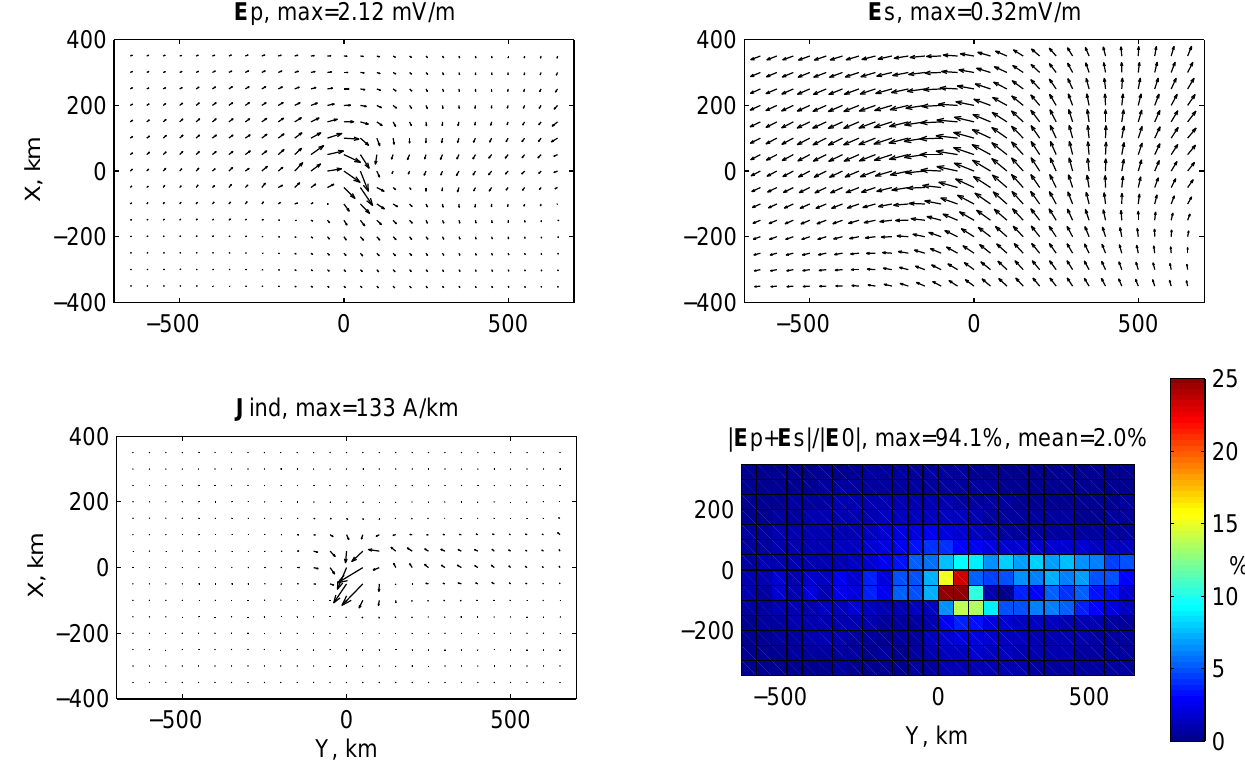
Fig. 5. Upper row: primary (left) and secondary (right) induced electric fields of the WTS model, note the different scales of the plots. Lower row: induced currents, i.e. currents driven by induced electric fields (left) and the ratio (primary+secondary induced electric field)/(driving electric field) (right). The color scale is limited to 25% while the maximum ratio is